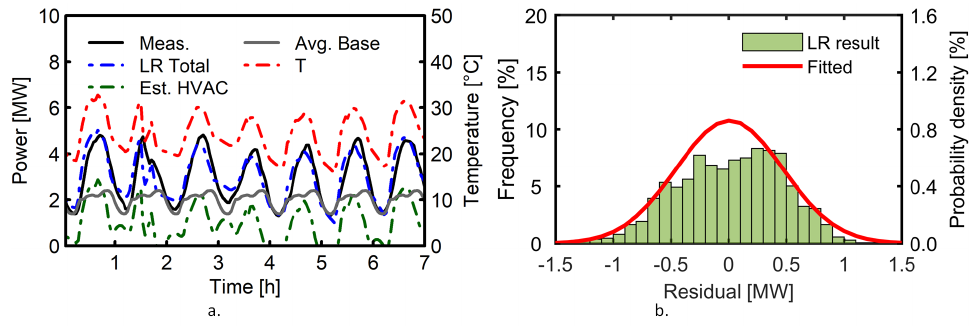
Figure 12. Example week following 20 June 2020 using a conventional linear regression (LR) model for the relationship between outdoor temperature and total electric power ( a ) Time ( b ) Residual. The error distribution of the LR model for total power is widely spread out, unlike the corresponding results for the newly proposed LSTM-based method shown in Figure